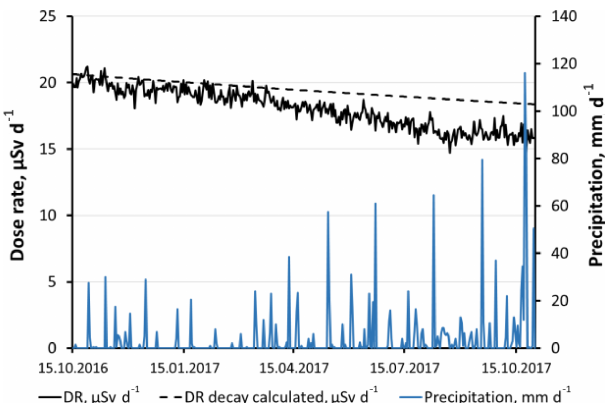
Figure 3. The time dependence of the D-shuttle readings (µSvd − 1 ) recorded from soil surface spot 10cm below the dosimeter for the site located in the catchment area of Funasawa pond (F), Okuma town and data on daily precipitation (mmd − 1 ) recorded by Tomioka meteorological station of Japan Meteorological Agency for the similar time window.